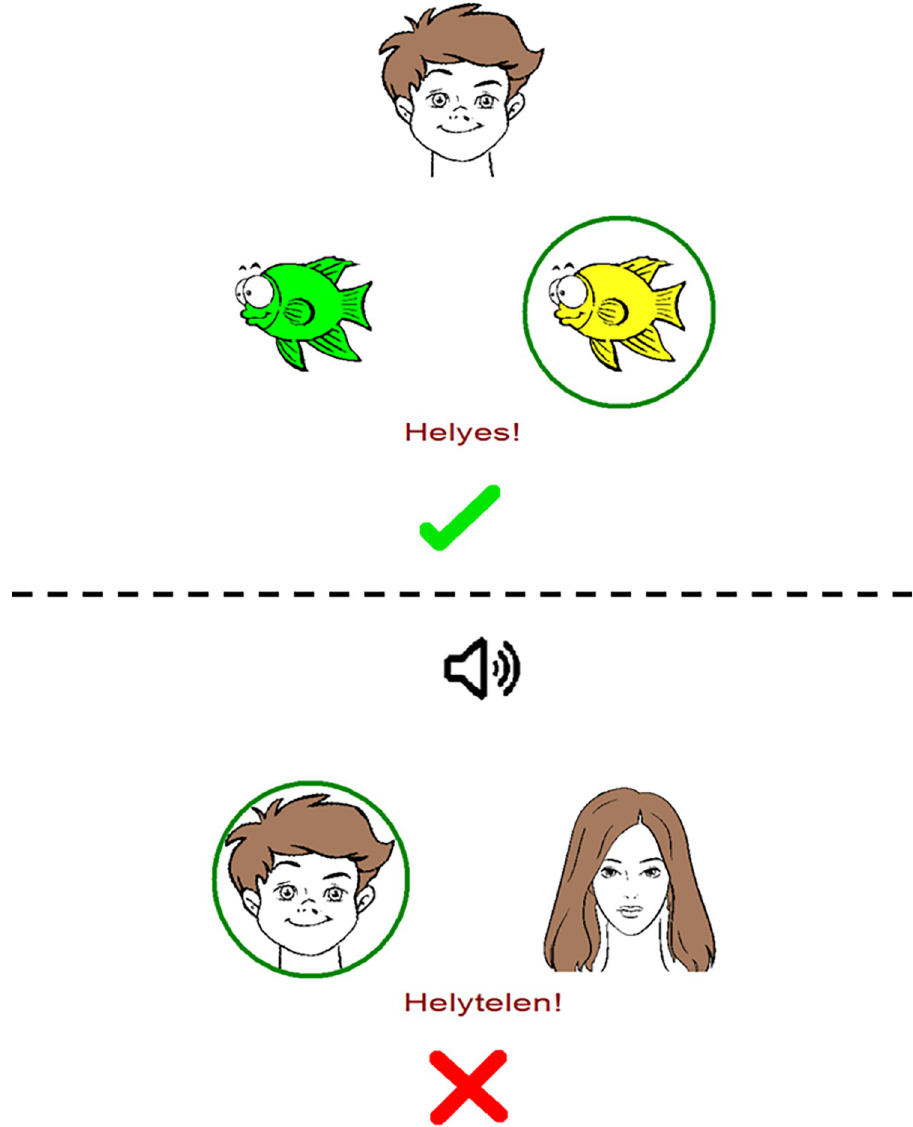
Fig 1. One trial from the visual (top) and the audiovisual (bottom) paradigms. Computer feedback to correct and incorrect responses (top and bottom, respectively) is also illustrated.